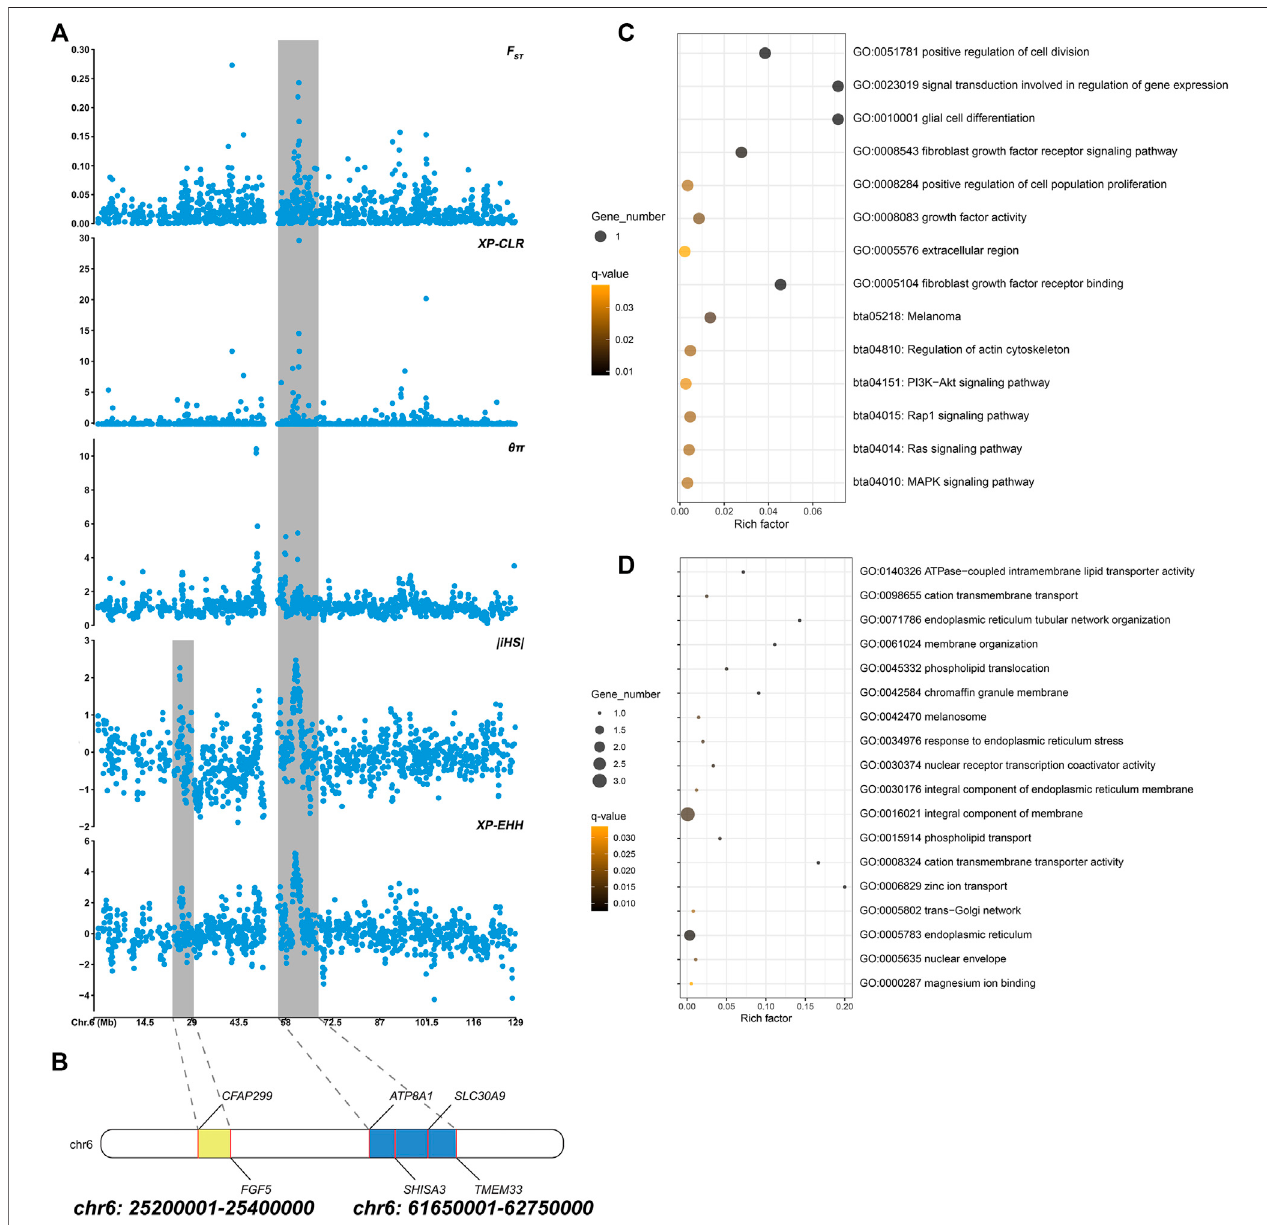
FIGURE 2 | (A) Manhattan plot of fi ve selection signals on chromosome 6. The two hotspots are marked with shading. (B) Genes identi fi ed in two hotspots. (C) Functional enrichment analysis of 0.2-MB hotspot. (D) Functional enrichment analysis of 1.1-MB